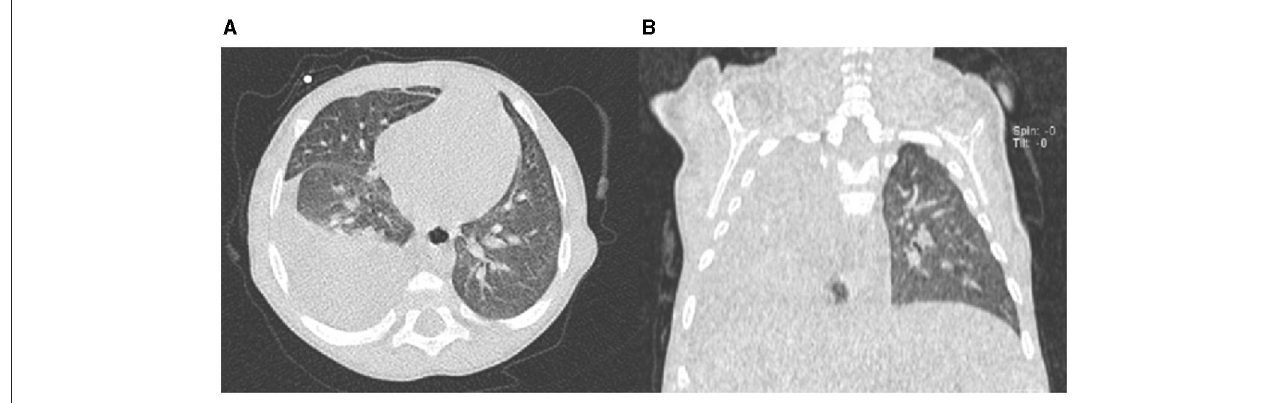
FIGURE 1 | Chest computed tomography (CT) scan axial view (A) and coronal view (B) showing right-sided pleural effusion.